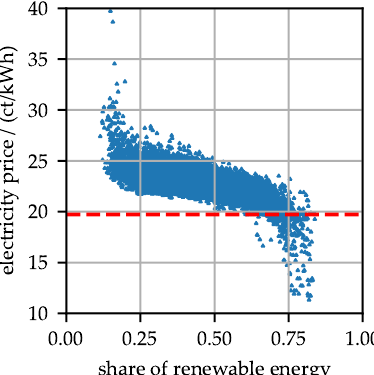
Figure 7. Hourly share of renewable energy versus hourly corresponding energy prices with a Pearson correlation coefficient of r = − 0.73 (Germany, 2020). The red line marks the basic fee per kWh of the chosen electricity tariff, prices below the red line correspond to negative prices at the stock market.